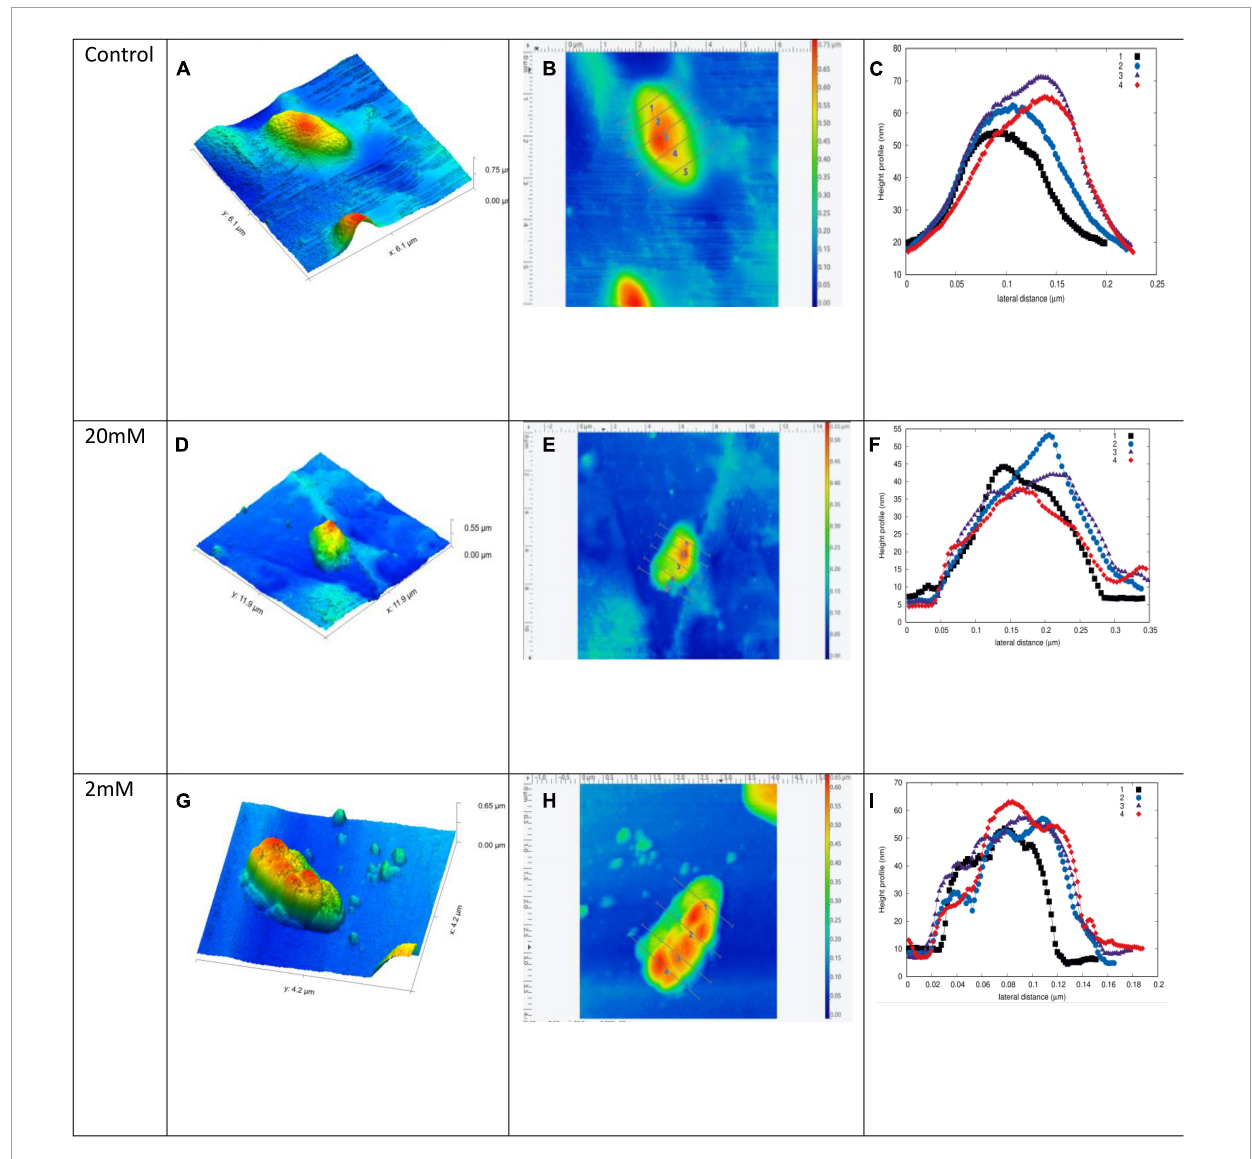
FIGURE7 Chromohalobacter sp. single cell surface topography as mapped under AFM. (A–C) Control without any treatment. Chromohalobacter sp. cells treated with 20 mM concentration of Mn (D–F) . Chromohalobacter sp. cells treated with 2 mM concentration of Mn (G–I) , where (A,D,G) indicate NC-AFM 3D height profile, (B,E,H) linear path mapping across single cell, (C,F,I) height profile graph of surface roughness for Chromohalobacter samples. Supplementary Figure 3 includes high resolution AFM images of single cell surface topography of Chromohalobacter sp. without Mn and with Mn